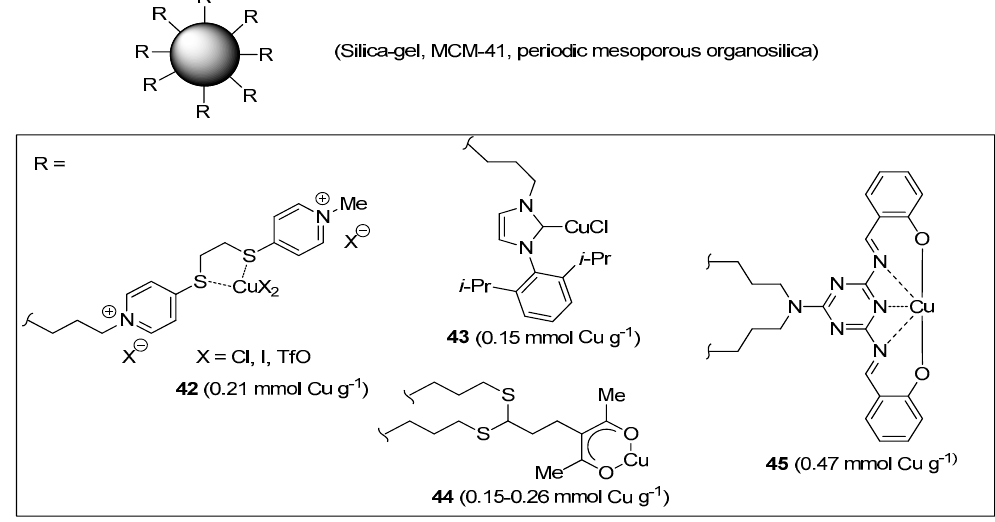
Figure 4. Cu(I/II) complexes with organic ligands covalently immobilized on insoluble inorganic